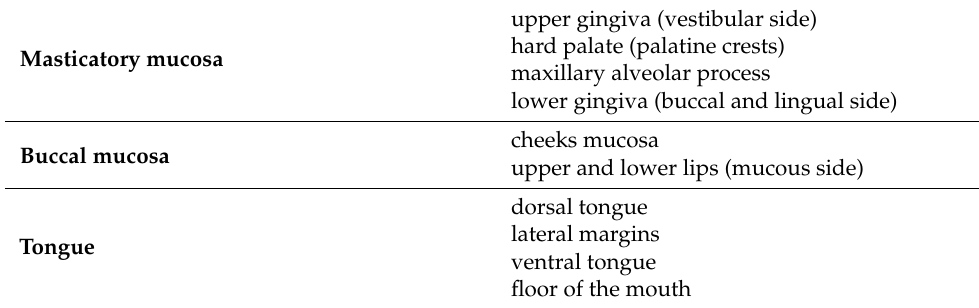
Figure 1. Two examples of ROI sampling in two anatomical regions of the oral cavity. ( a ) Dorsal tongue: (1) epithelium, (2) rete ridges, (3) connective layer, (4) muscle layer. ( b ) Ultrasound imaging of the upper gingiva and alveolar bone (masticatory mucosa): (1) epithelium, (2) rete ridges, (3) connective layer, (4) alveolar bone. Table 1. Regions and specific areas of the oral cavity scanned with ultrasonography.